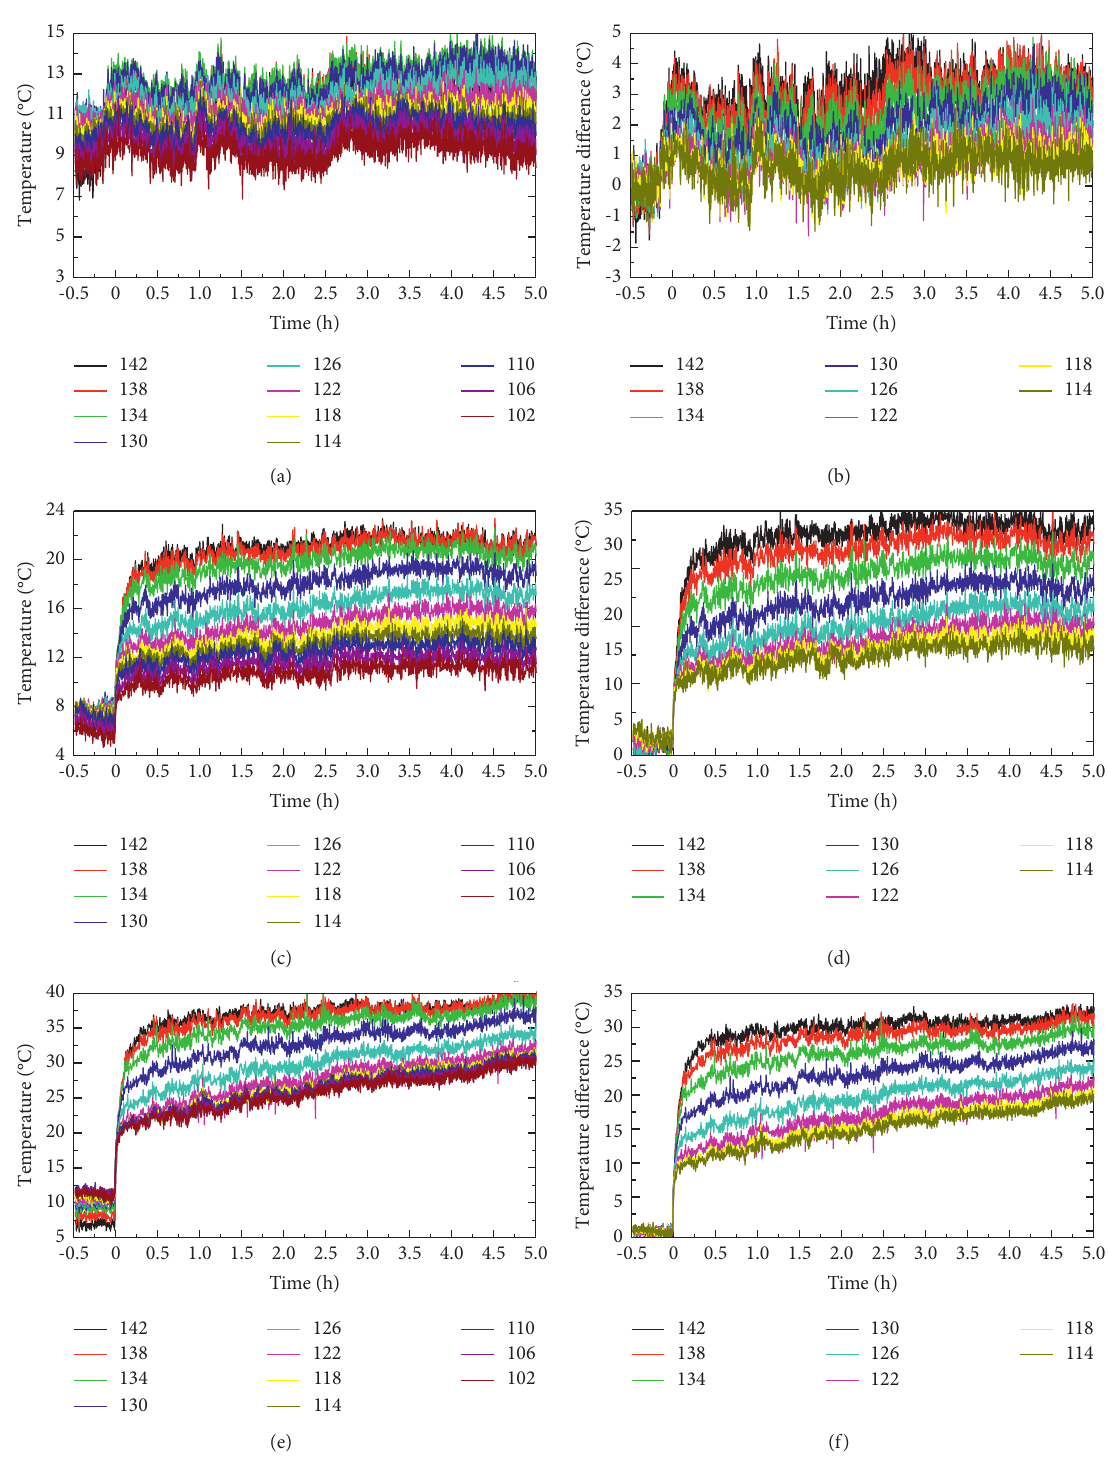
Figure 4: Variation of original temperature ((a) 5A; (c) 10A; (e) 15A) and temperature difference ((b) 5A; (d) 10A; (f) 15A) with